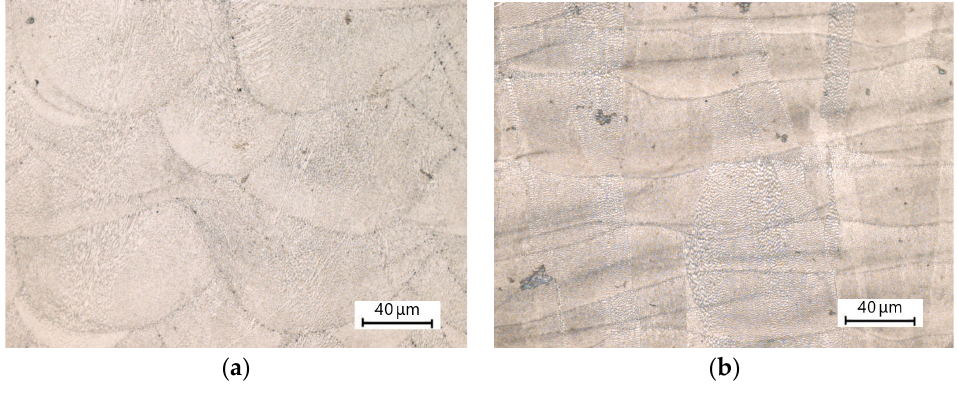
Figure 8. Metallographs of specimens: ( a ) N5, ( b ) N7.